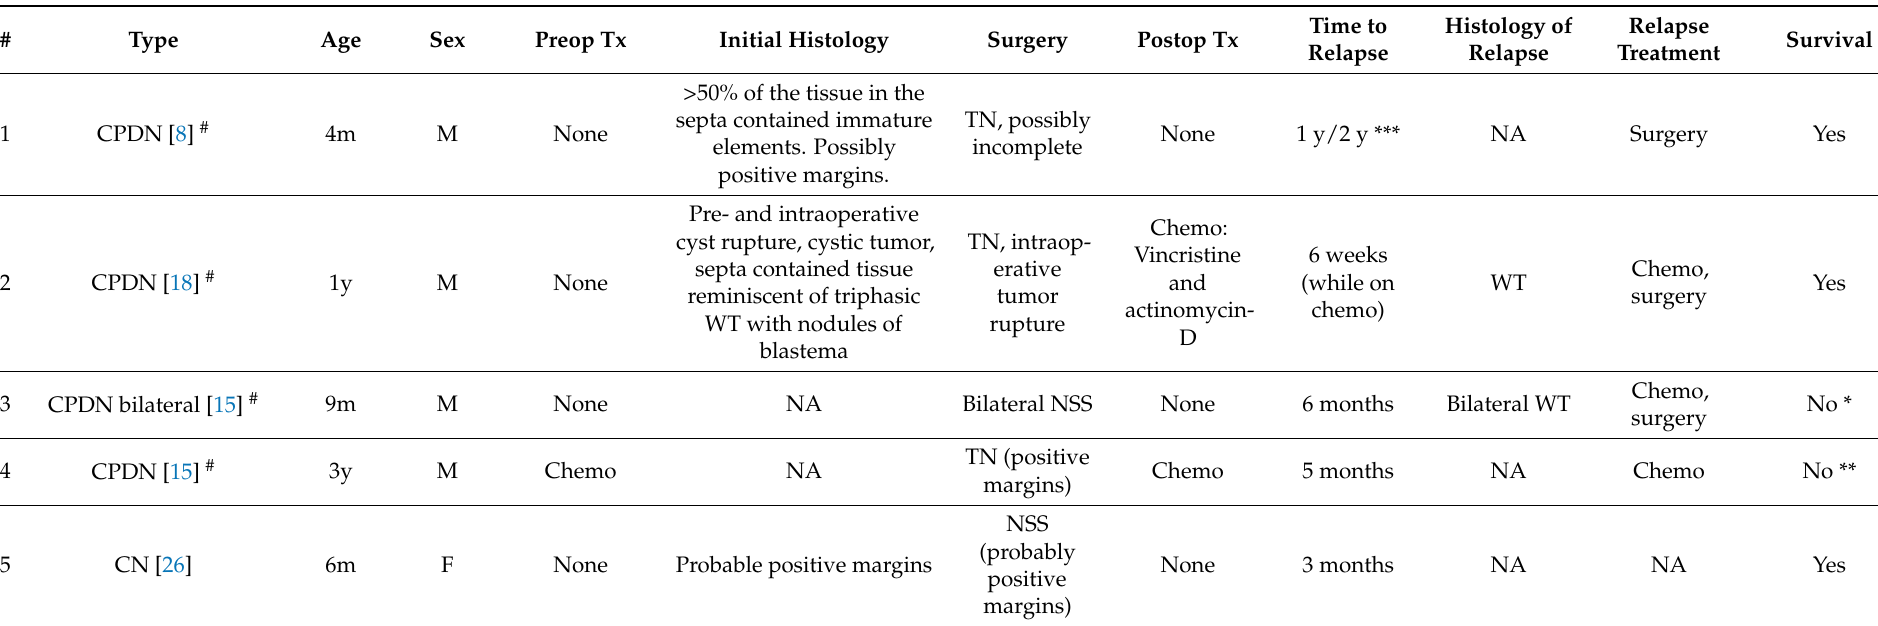
Table 3. Clinical and treatment characteristics of relapsed